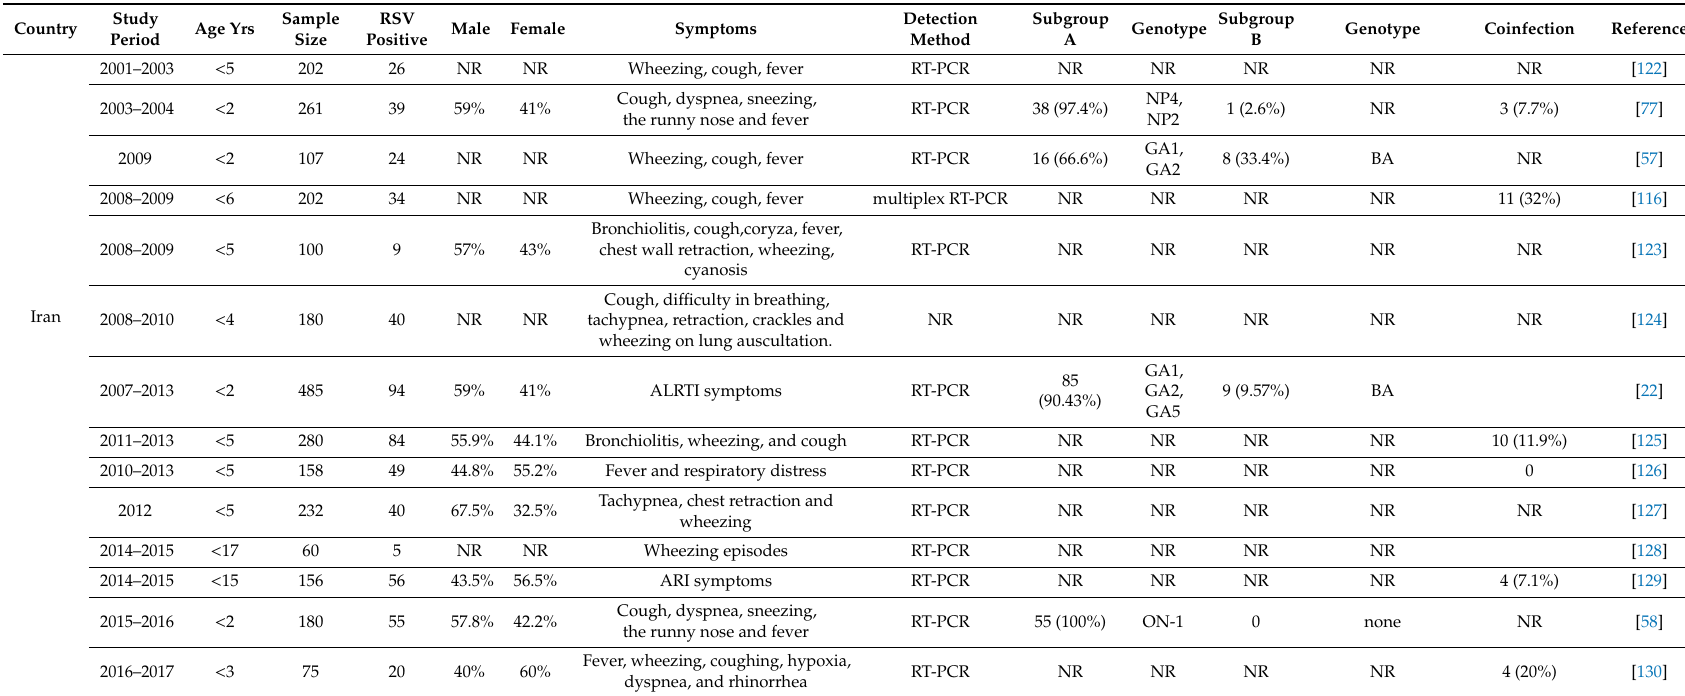
Table A1. The prevalence of RSV and associated demographics in 16 countries of the MENA